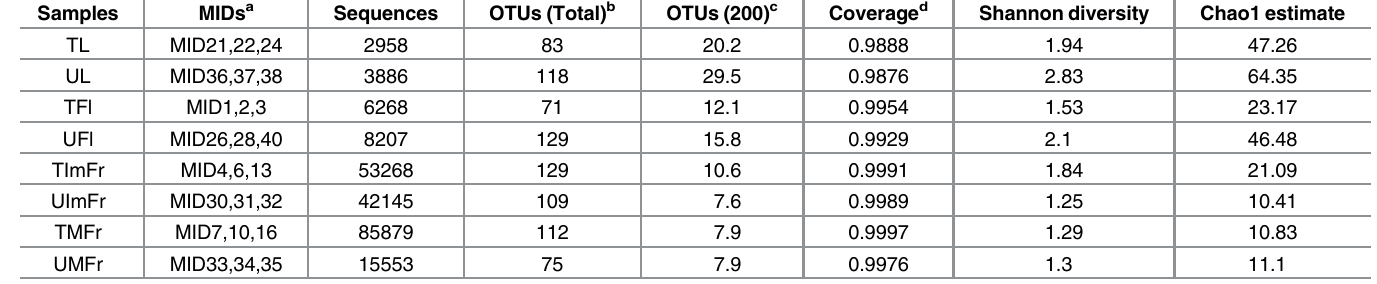
Table 1. Summary of analyses and results of metagenomic surveys conducted with treated (T) and untreated (U) leaves (TL and UL), flowers (TFl and UFl), immature fruit (TImFr and UImFr), and mature fruit (TMFr and UMFr).